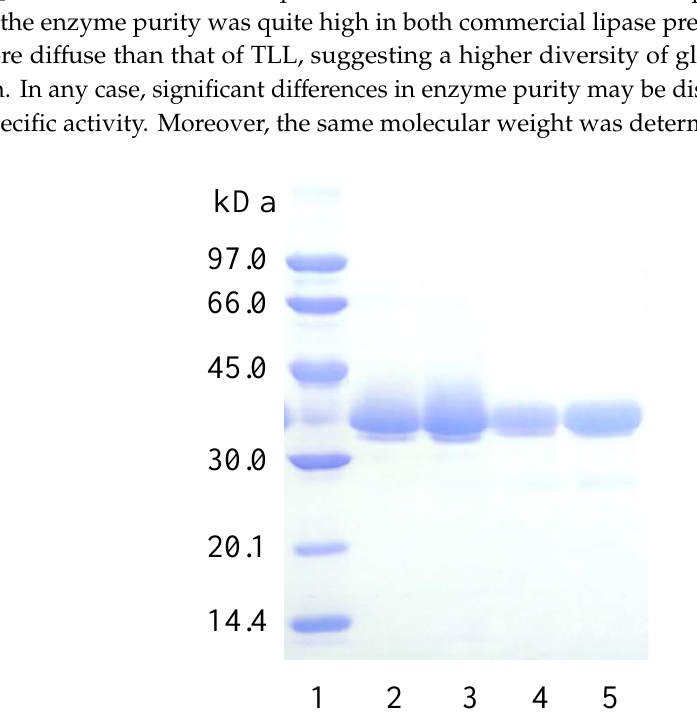
Figure 1. SDS-PAGE analysis of di ff erent Thermomyces lanuginosus (TLL) and Eversa ® Transform (ET) preparations. All the samples were prepared at 0.35 mg protein / mL. Lane 1: low molecular weight markers; lane 2: ET-octyl; lane 3: free ET; lane 4: TLL-octyl; lane 5: free TLL. Experiments were performed as described in the Methods section.